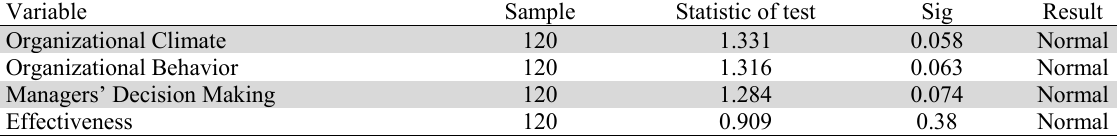
The results of Kolmogorov-Smirnov test for the evaluation of